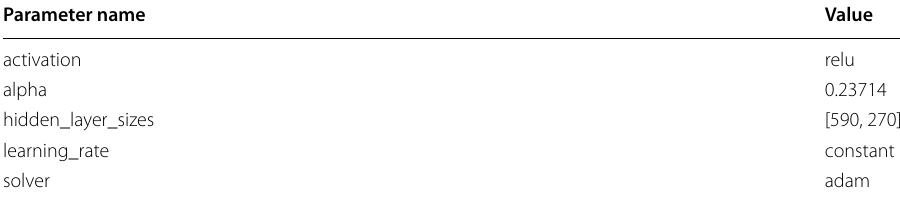
Table 91 Modes of MLP tuned hyperparameter values for experiments with the data exfiltration dataset